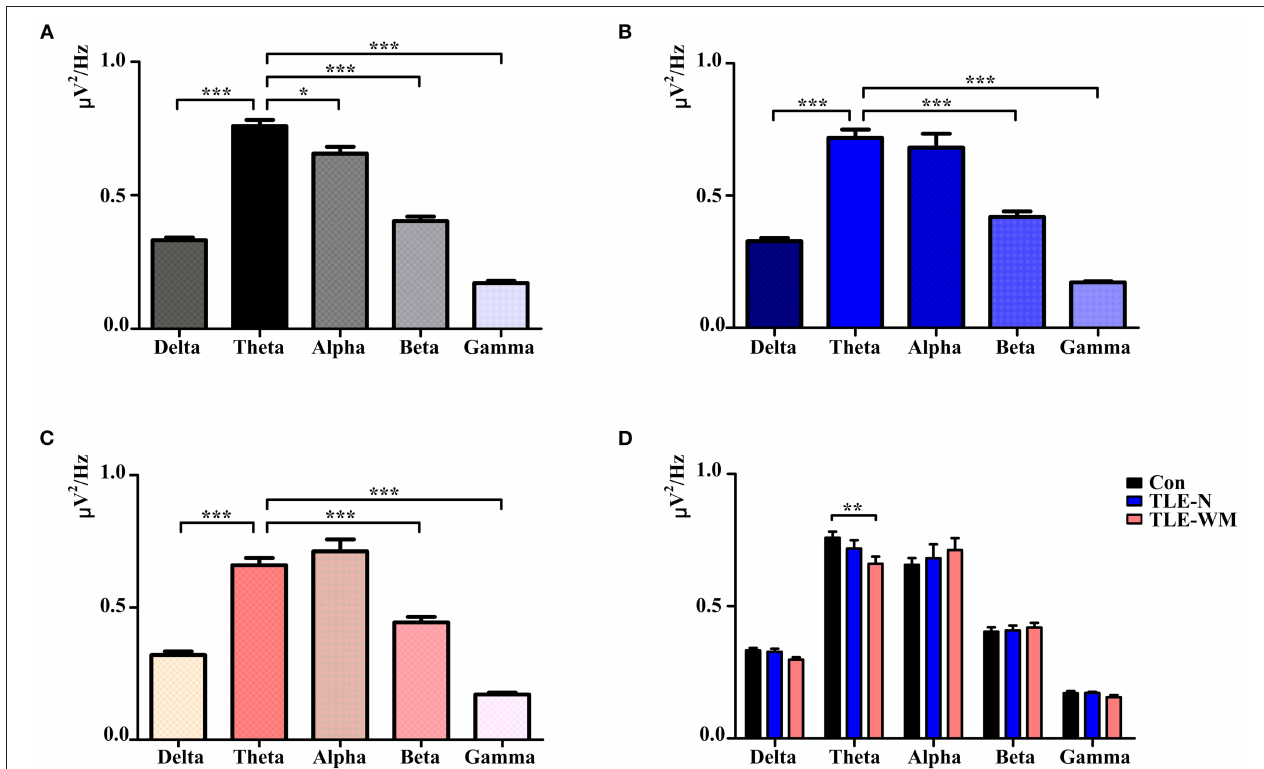
FIGURE 3 | Neural oscillations during the WM encoding phase across the three groups. Comparisons of PSD values among the delta, theta, alpha, beta, and gamma frequencies in the Con group (A) , TLE-N group (B) , and TLE-WM group (C) . (D) Comparisons of PSD values associated with different frequency bands among the three groups. * p < 0.05, ** p < 0.01, and *** p < 0.001.